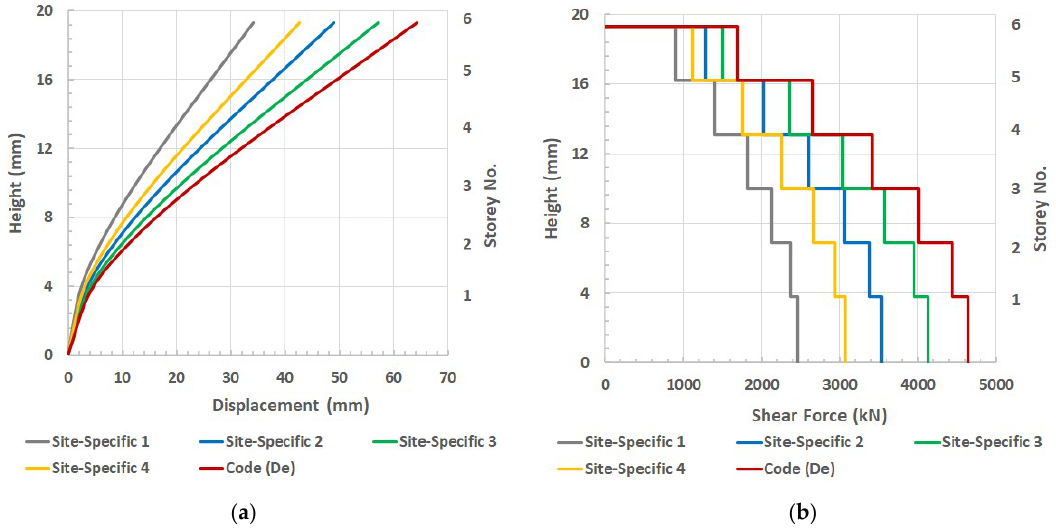
Figure 7. Analysis results for CSB 1: ( a ) storey displacement and ( b ) storey shear.